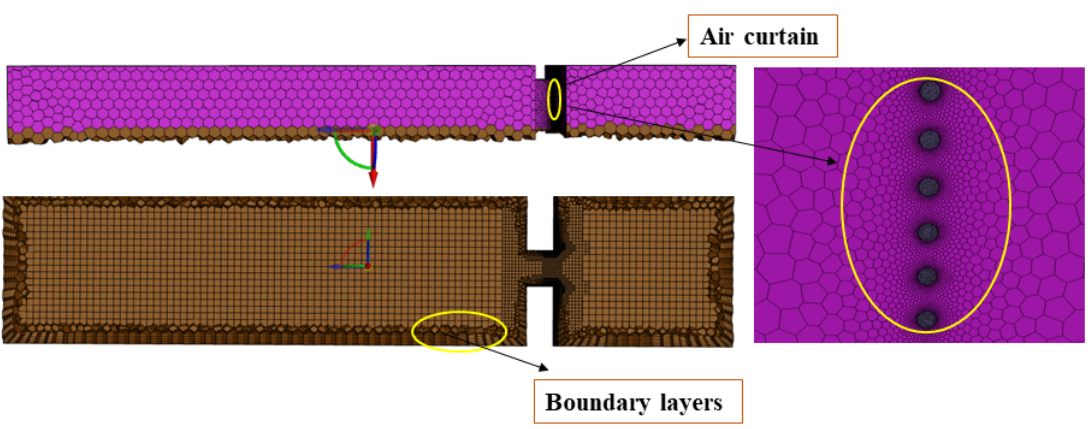
Figure 6. Grid display of the model.